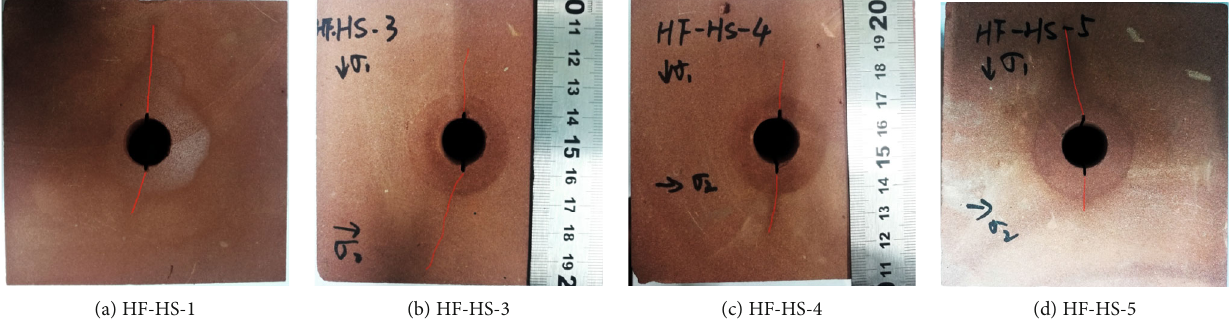
Figure 7: Fracture morphology of the red sandstone specimens after hydraulic fracturing.